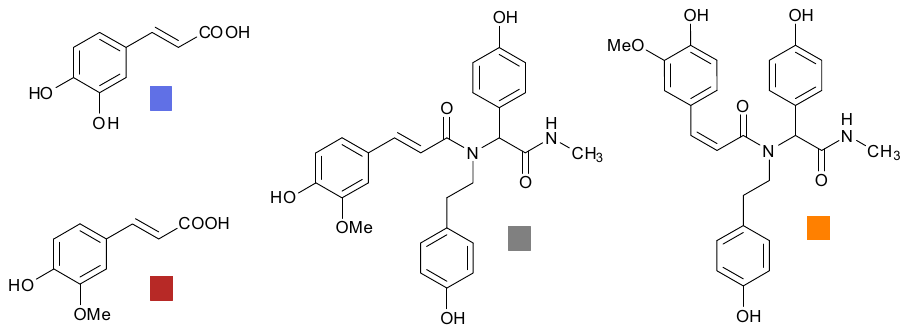
Figure 1. Stability of CA, FA, and FEF77 isomers at room temperature in PBS pH 7.4.